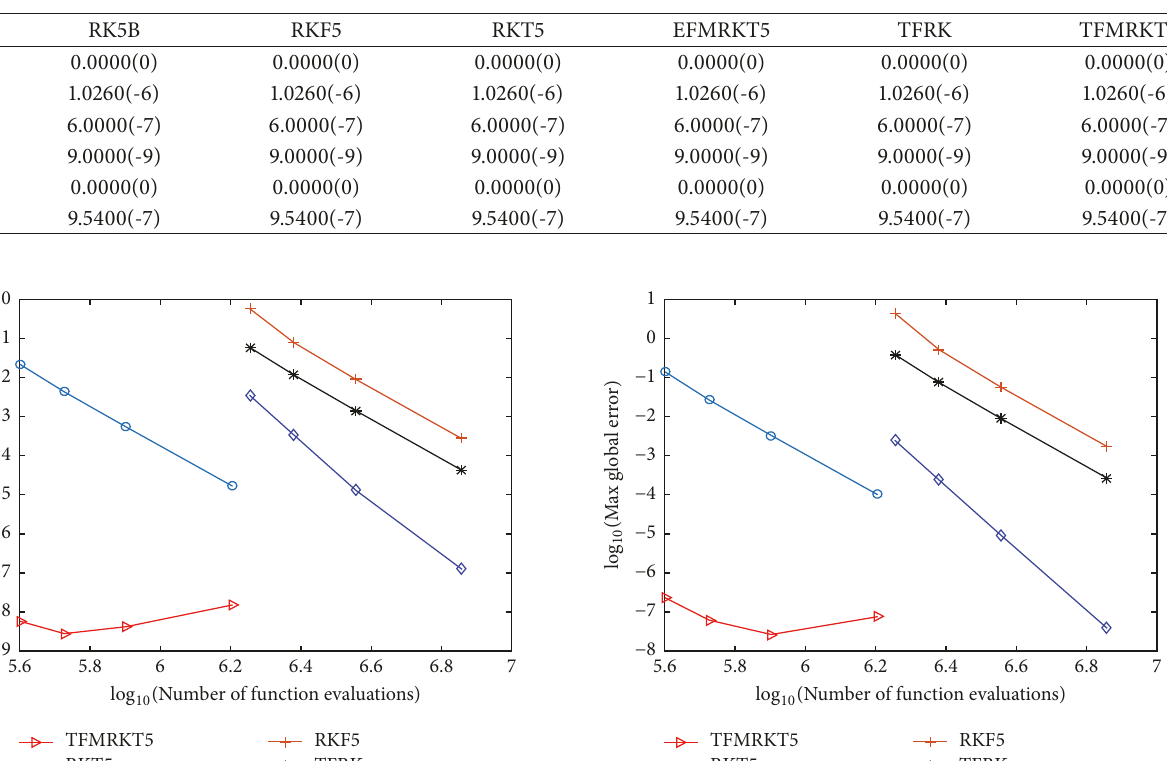
Table 7: Comparison of error for problem in thin film flow (58) taking ℎ = 0.01 and 𝑘 = 2 .